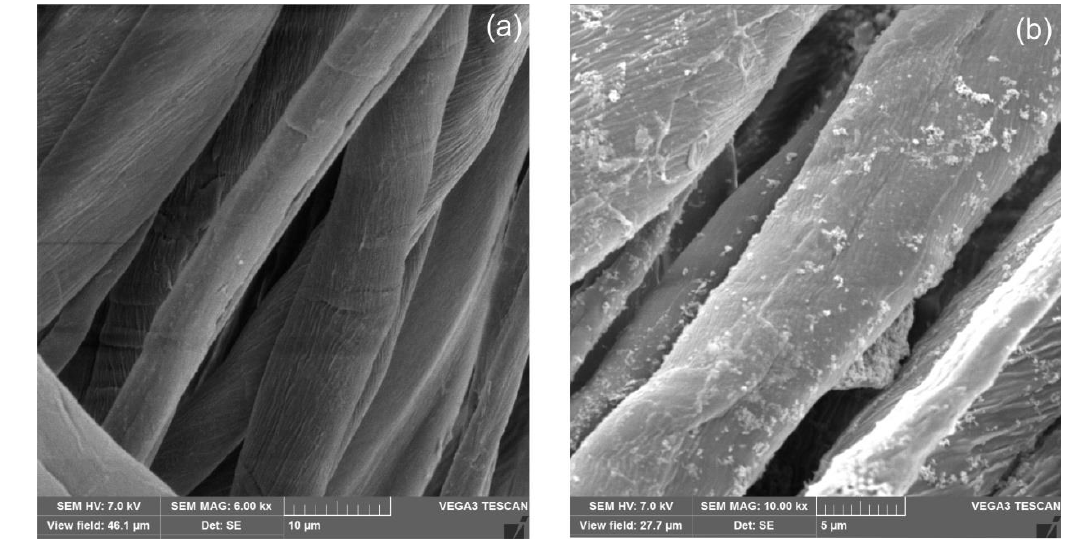
Figure 4. SEM images of ( a ) unmodified and ( b ) ZnO and TiO 2 modified cotton terry towels.